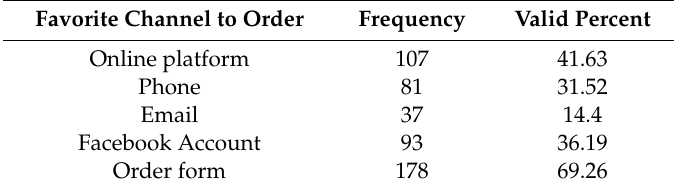
Table 5. The frequency of the preferred channels for placing orders (N =